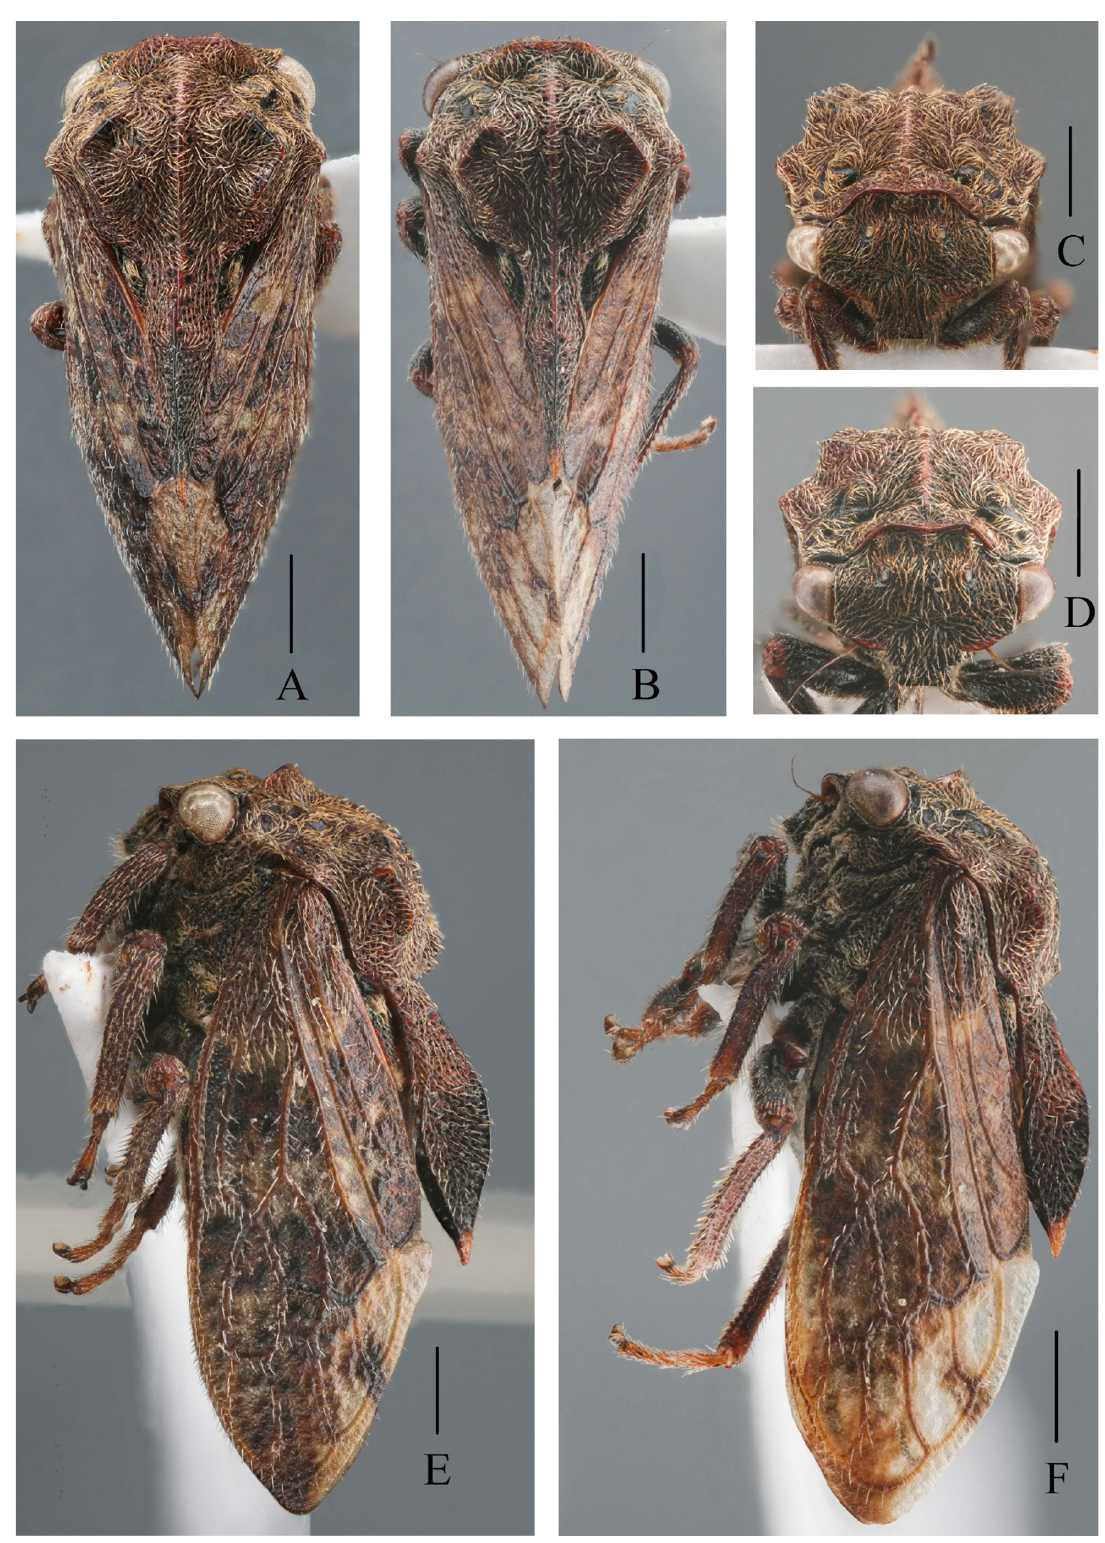
Fig. 1. Machaerotypus stigmosus Li & Chen sp. nov. A, C, E . Paratype, ♀ (IEGU), habitus in dorsal, frontal and lateral view. B, D, F . Paratype, ♂ (IEGU), habitus in dorsal, frontal and lateral view. Scale bars = 1